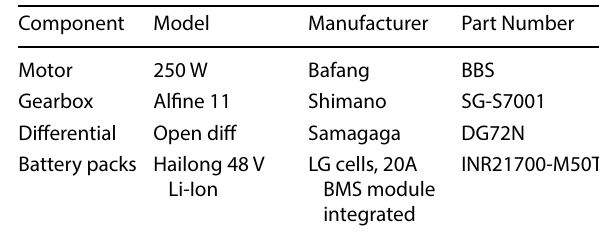
Table 2 Main technical specifications of SNAP Mid-drive transmis-